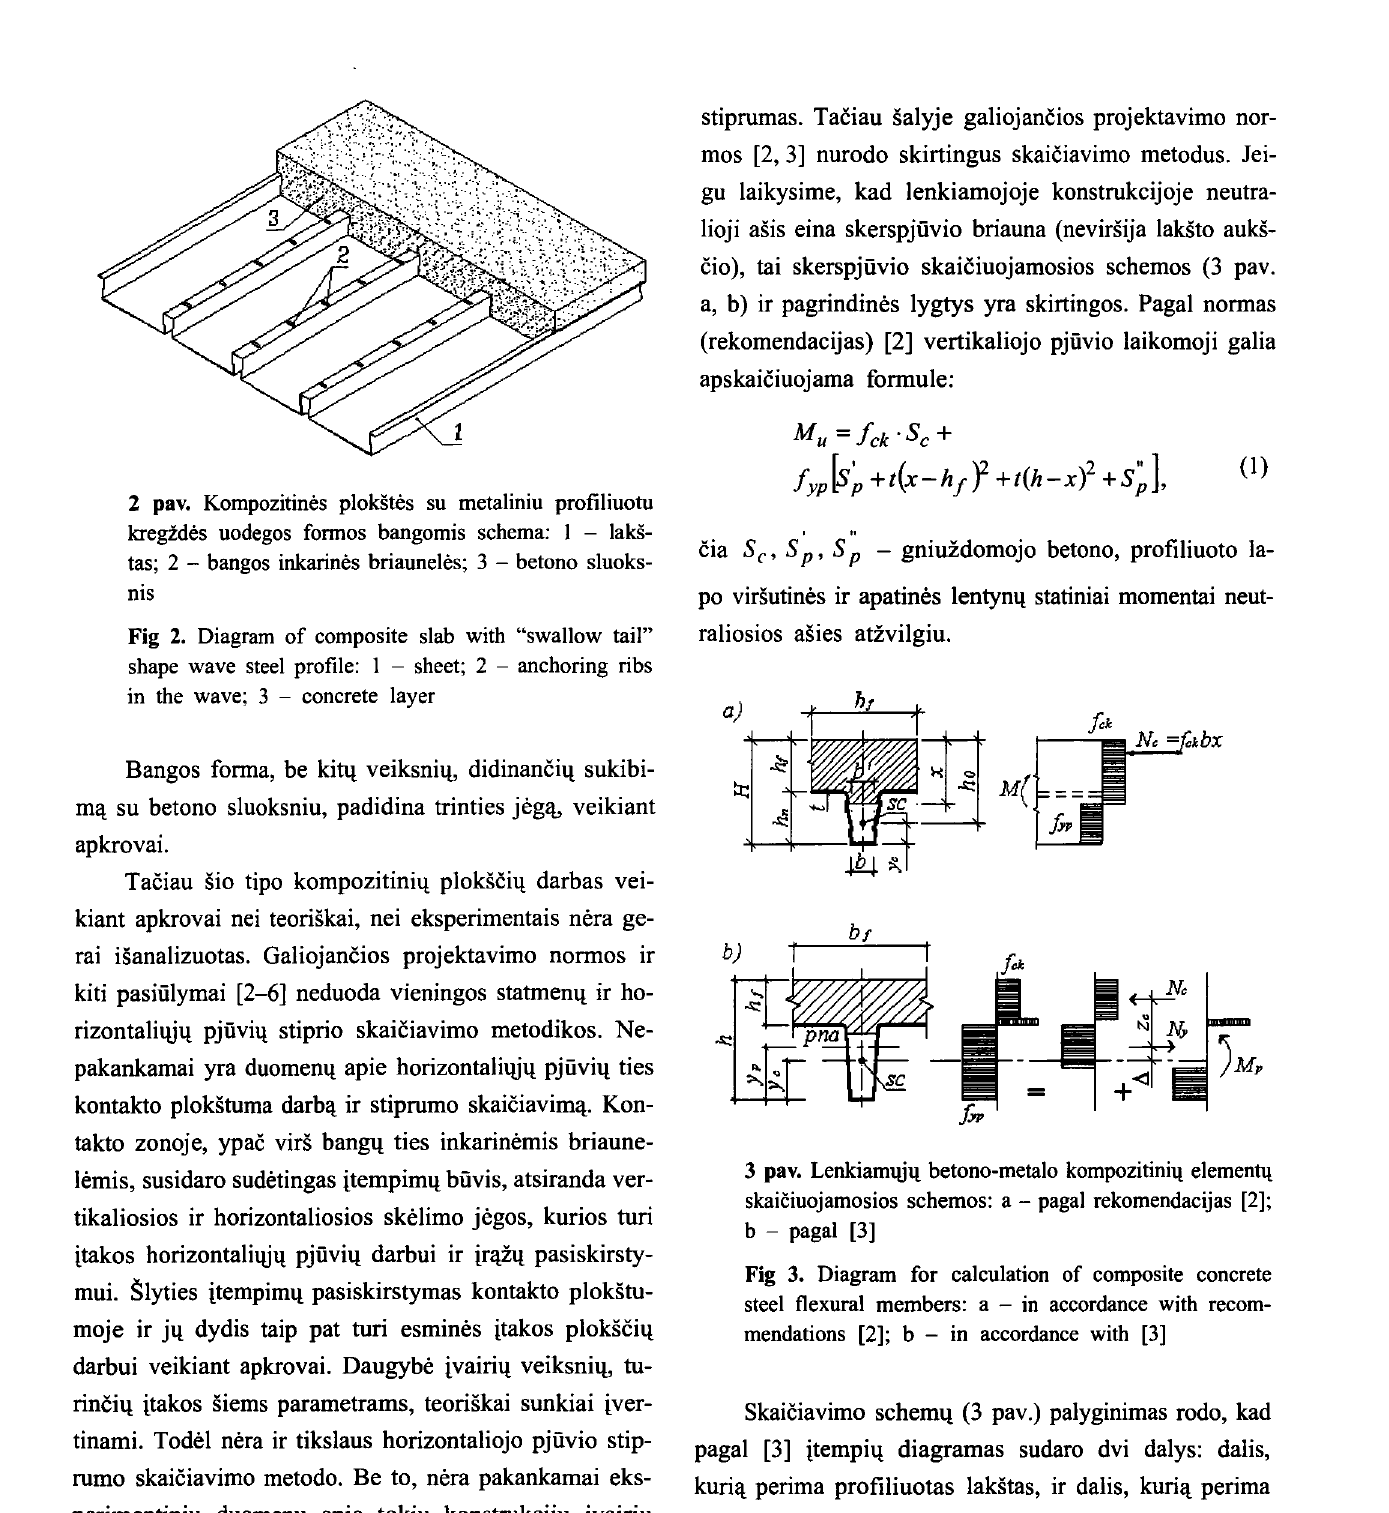
Fig 2. Diagram of composite slab with "swallow tail" shape wave steel profile: I - sheet; 2 - anchoring ribs in the wave; 3 - concrete layer Bangos fonna, be kitll veiksniq, didinanCiq sukibi ffil!: su betono sluoksniu, padidina trinties jegl!:, veikiant apkrovai.